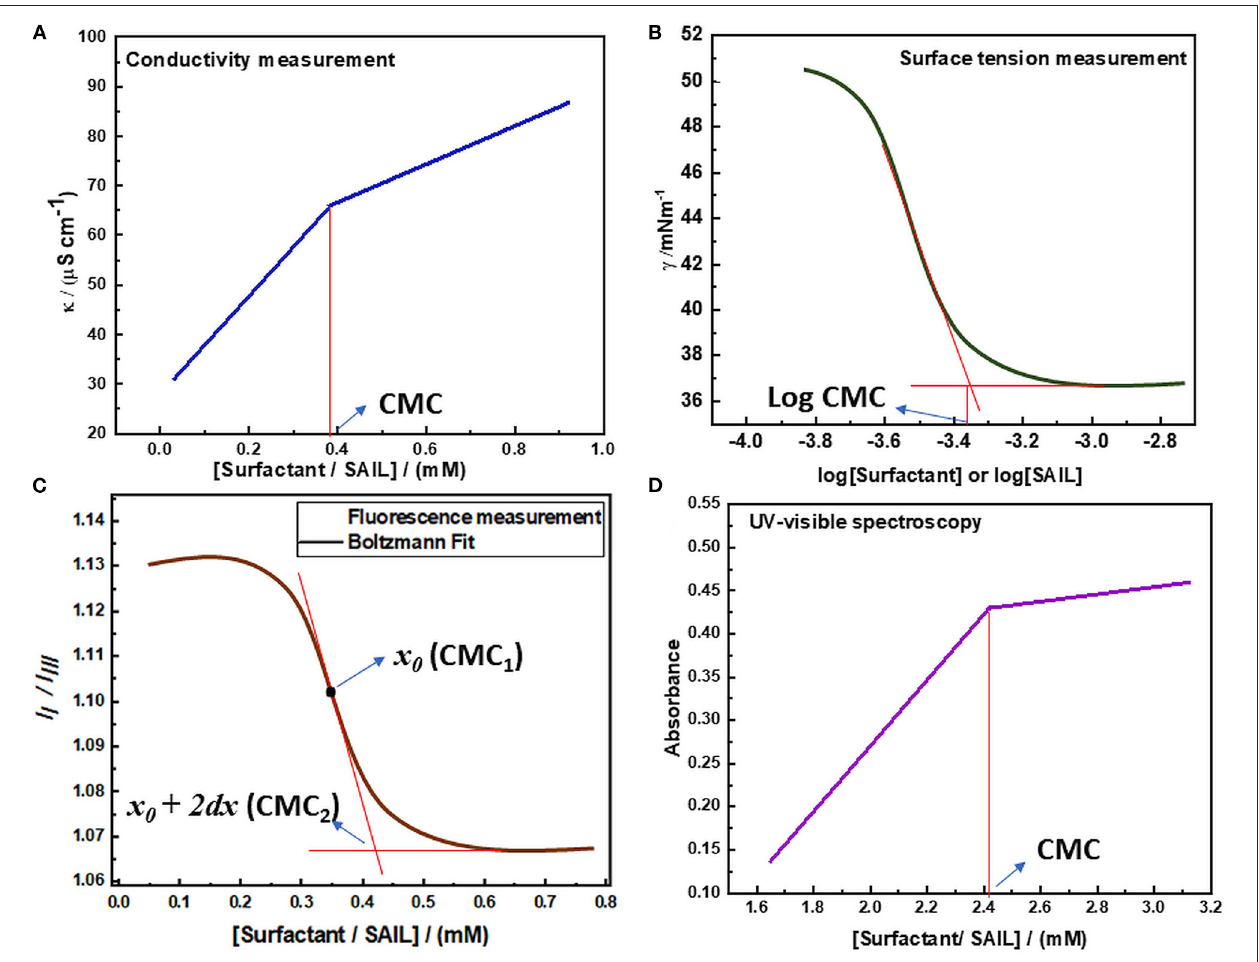
FIGURE 6 | Determination of CMC via (A) Conductivity measurement (B) Surface tension measurement (C) Fluorescence measurement (D) UV-visible